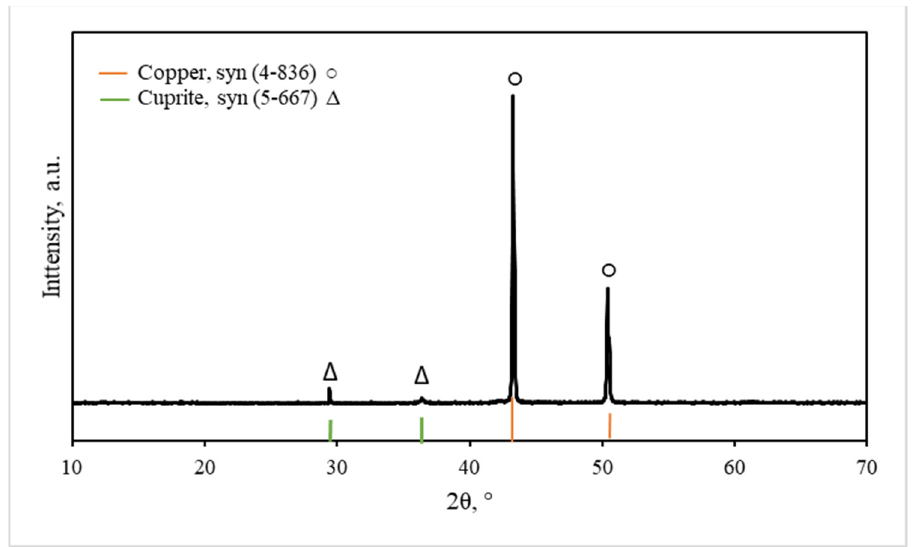
Figure 2. X-ray diffractogram of the particles formed: X-ray experimental diffractogram (top), X-ray diffractograms of Cu (4–836) and Cu 2 O (5–667) according to JCPDS data